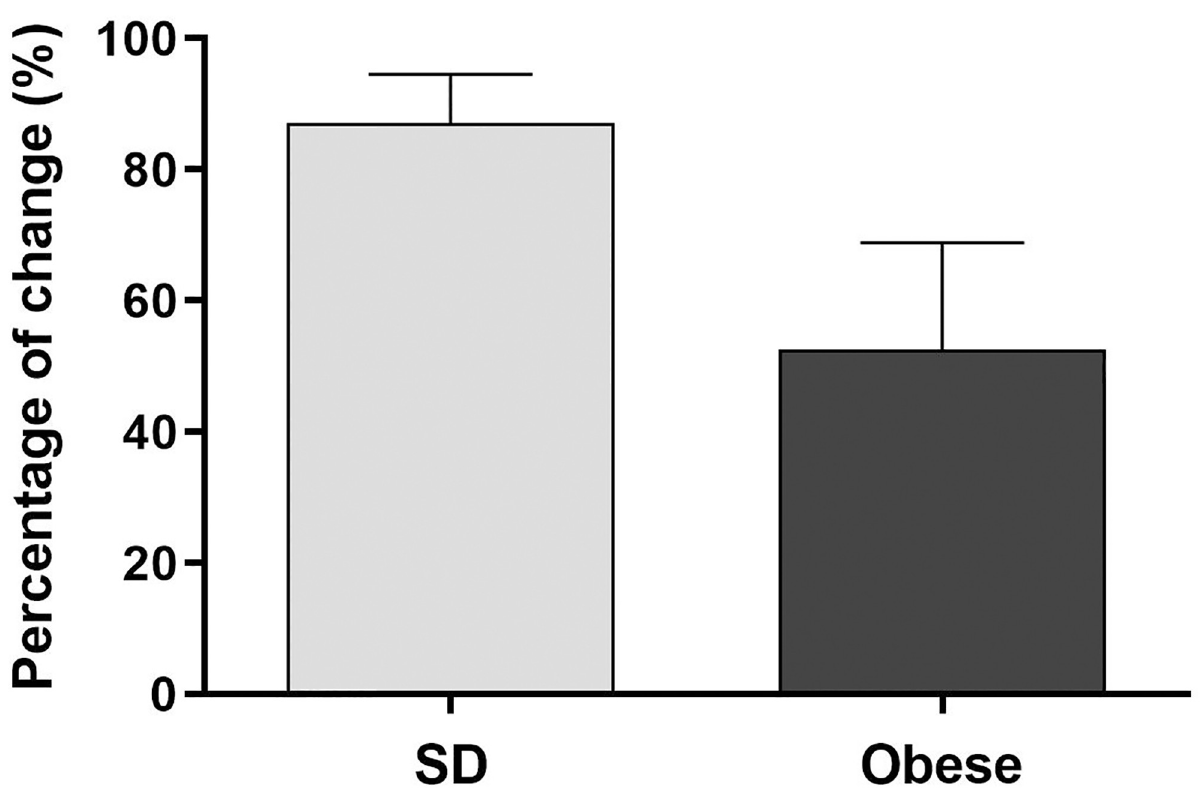
Fig 9. Effect of histamine in SD mice compared to obese mice. The graph illustrates the percentage of change (%) in diameter of SD mice compared to obese mice after stimulation with histamine. n = 4 mice per group. Data represent the mean ±